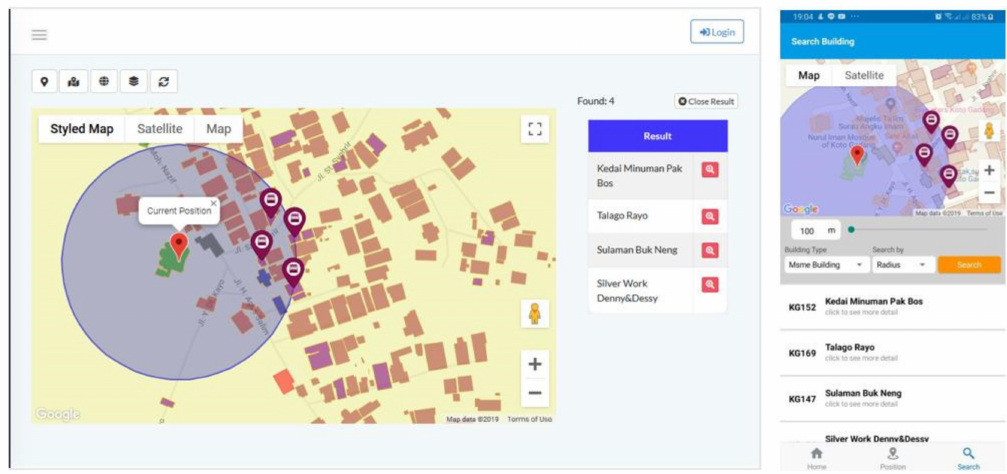
Figure 10. MSME building search around the tester’s